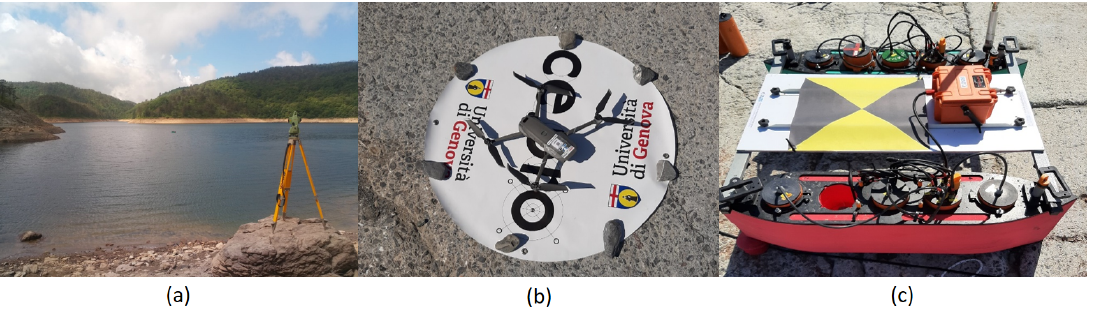
Figure 1. Instrumentation used through the survey campaign execution; ( a ) the Total station, ( b ) the UAV to perform topographic photogrammetric survey, ( c ) the SWAMP that carried out the bathymet- ric survey.